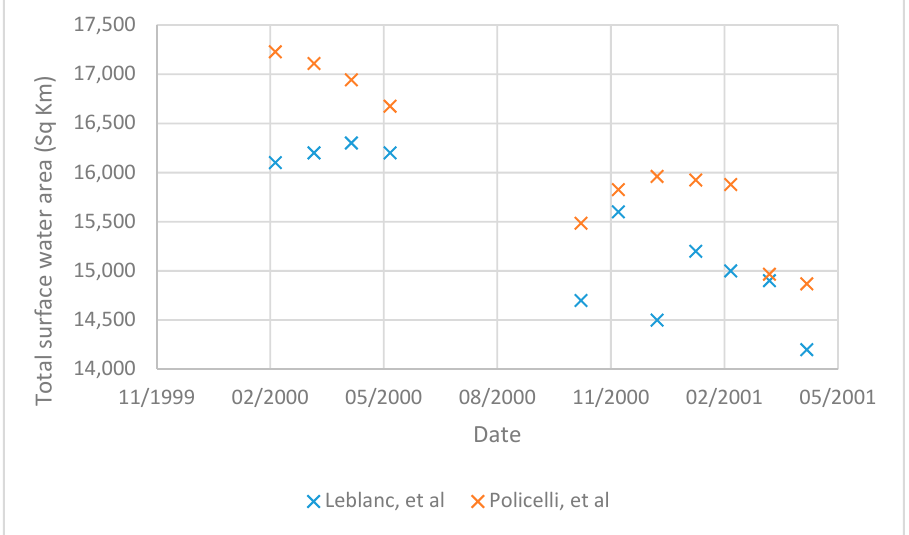
Figure 7. Comparison of Lake Chad total surface water area estimates using NASA MODIS Land Surface Temperature (LST) from this study with results from [10].